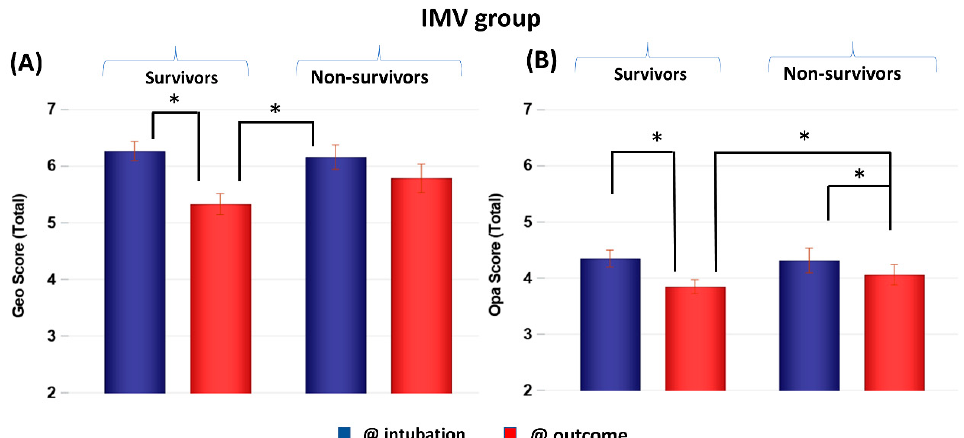
Figure 3. ( A ) Geographic extent (Geo) and ( B ) opacity (Opa) CXR scores of IMV patients taken at intubation and outcome stratified by survivors ( N = 118) and non-survivors ( N = 59). * p < 0.05. Error bars: SEM.